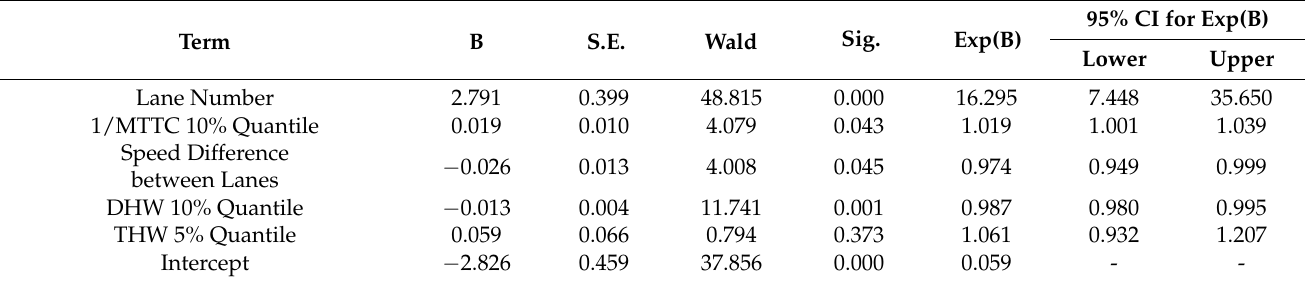
Table 2. Impact Analysis of feature variables on regional